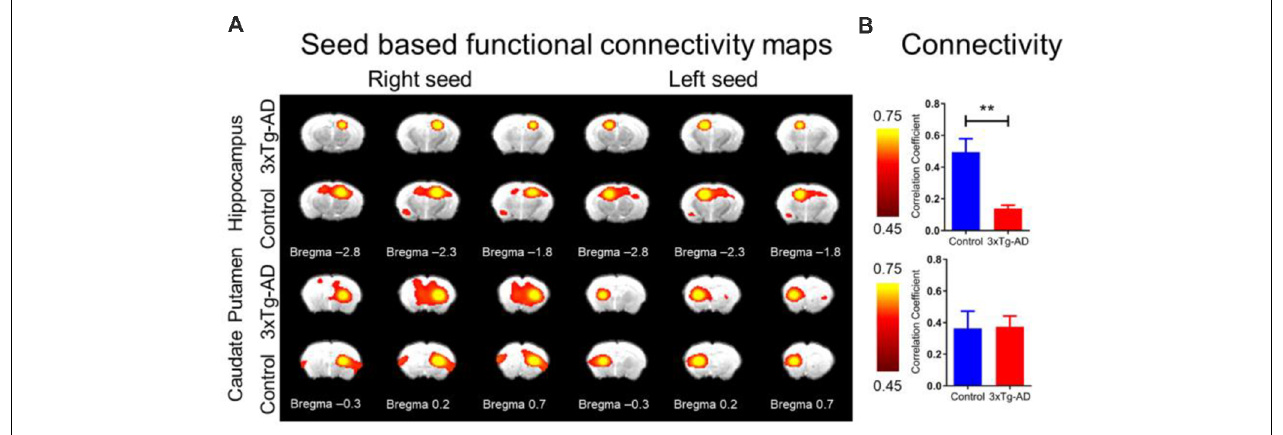
FIGURE 5 | The rsfMRI connectivity change in 3xTg-AD compared with controls. (A) SBA in 3xTg-AD and control FC maps of hippocampus (upper panel) and CPu (lower panel) for right and left hemisphere seed. The ROI for hippocampus and CPu were derived from Franklin and Paxinos (2008) overlay Figure 1A. Note significantly reduced FC in left or right seed for 3xTg-AD in the hippocampus, but relatively unchanged for CPu. Color bar represents correlation coefficient from 0.75 yellow to 0.45 red. (B) Bar plots of average FC in hippocampus (upper) and CPu (lower) for the 3xTg-AD (red) and control (blue) groups. Color bar represents correlation coefficient. The asterisk ∗∗ indicates highly significant P <